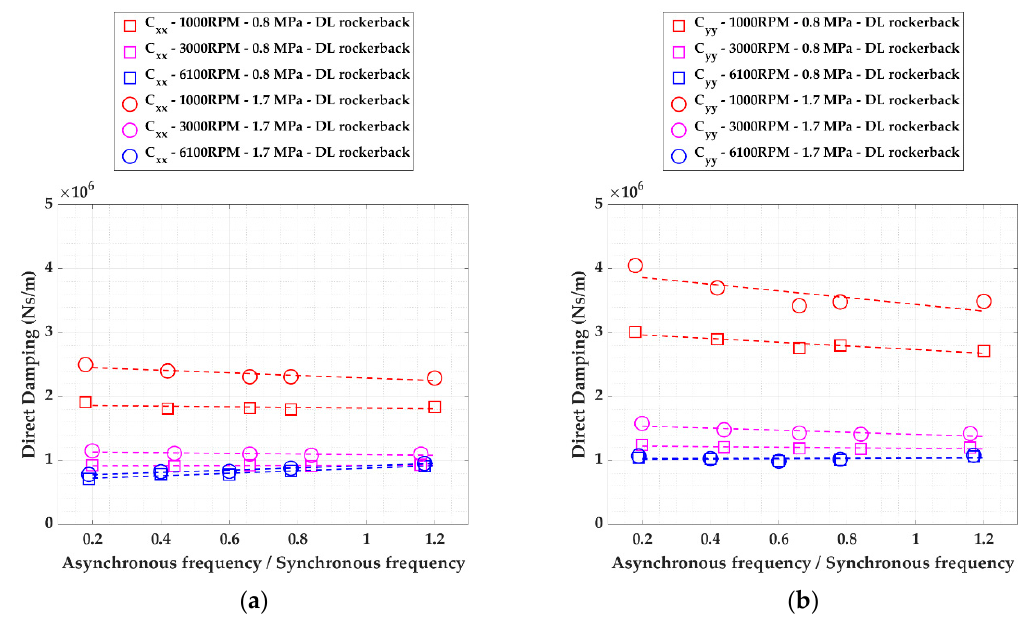
Figure 26. Direct Lube Rocker Pivot bearing asynchronous direct coefficients at various speeds for 0.8 MPa and 1.7 MPa: ( a ) C xx , ( b ) C yy .